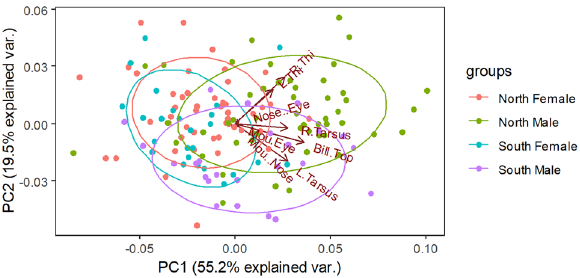
Figure 4. The principal component plot represents the multivariate dataset of the morphological variables of Painted Stork; the first principal component (PC 1 ) is plotted along the x-axis, and the second principal component (PC 2 ) along the y-axis. NF North Female, NM North Male, SF South Female, SM South Male.